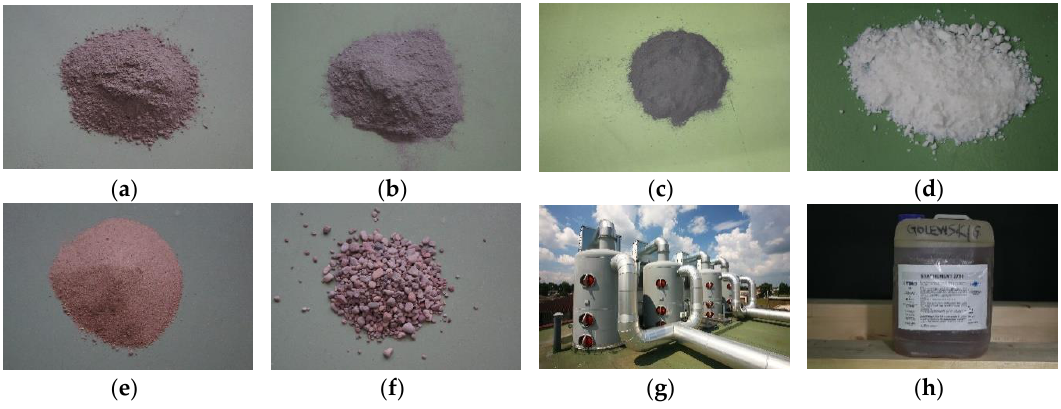
Figure 5. Appearance of materials used in the studies: ( a ) cement; ( b ) fly ash; ( c ) silica fume; ( d ) nanosilica; ( e ) fine aggregate; ( f ) coarse aggregate; ( g ) water; and, ( h )